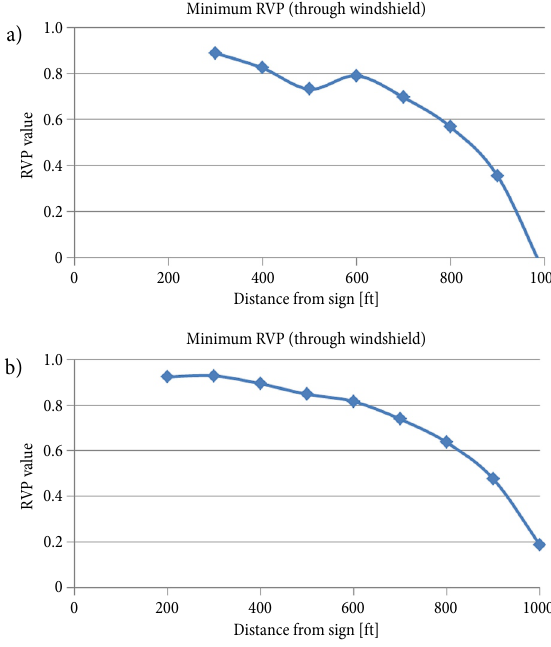
Fig. 7. Minimum RVP values for a green overhead sign at different distances: a – ASTM Type III material; b – ASTM Type XI